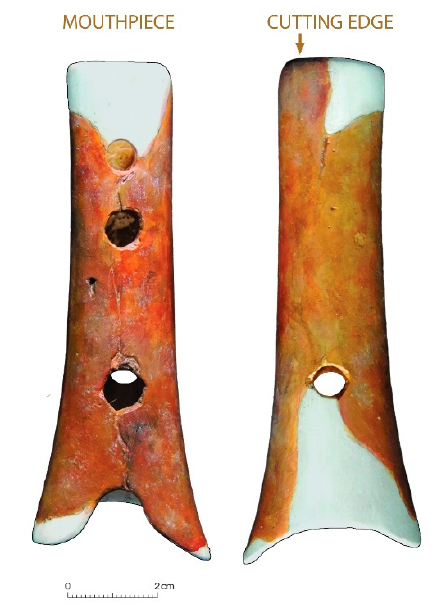
Figure 6. Reconstruction of the Neanderthal musical instrument from Divje babe I. The reconstructed parts are in white plaster. The position of the bevelled cutting edge of the mouthpiece is marked by an arrow (photo Tomaž Lauko, NMS).